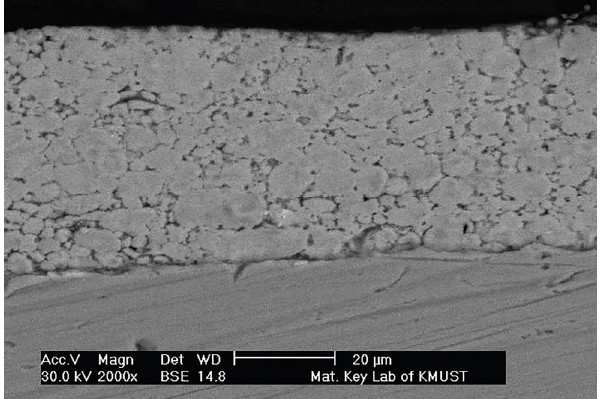
Fig. 15 Scanning electron micrograph image of the distinct coating/substrate interface observed. Reproduced with permission from Ref. [86], © Elsevier, 2013.